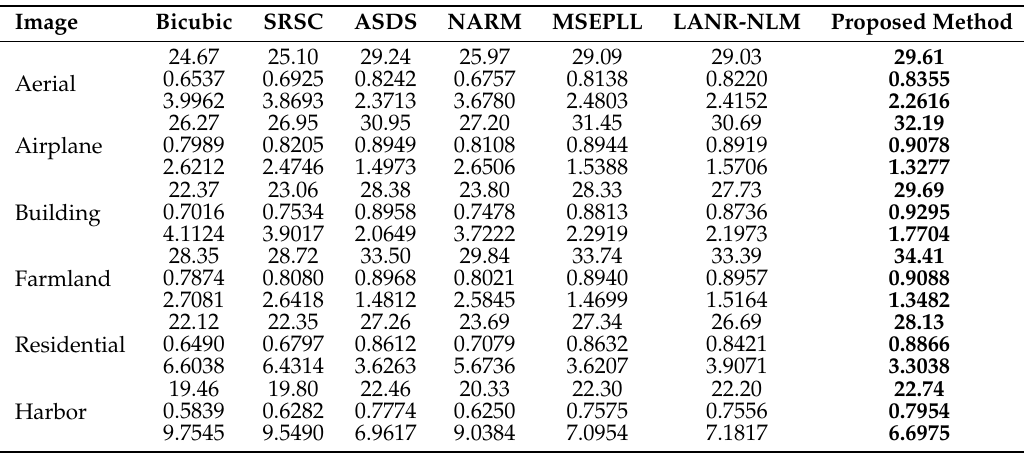
Table 2. PSNR, SSIM (Structural Similarity Index) and ERGAS (Erreur Relative Globale Adimensionnelle De synthèse) Results of Reconstruction for Test Images (Scale Factor = 3, Noise =